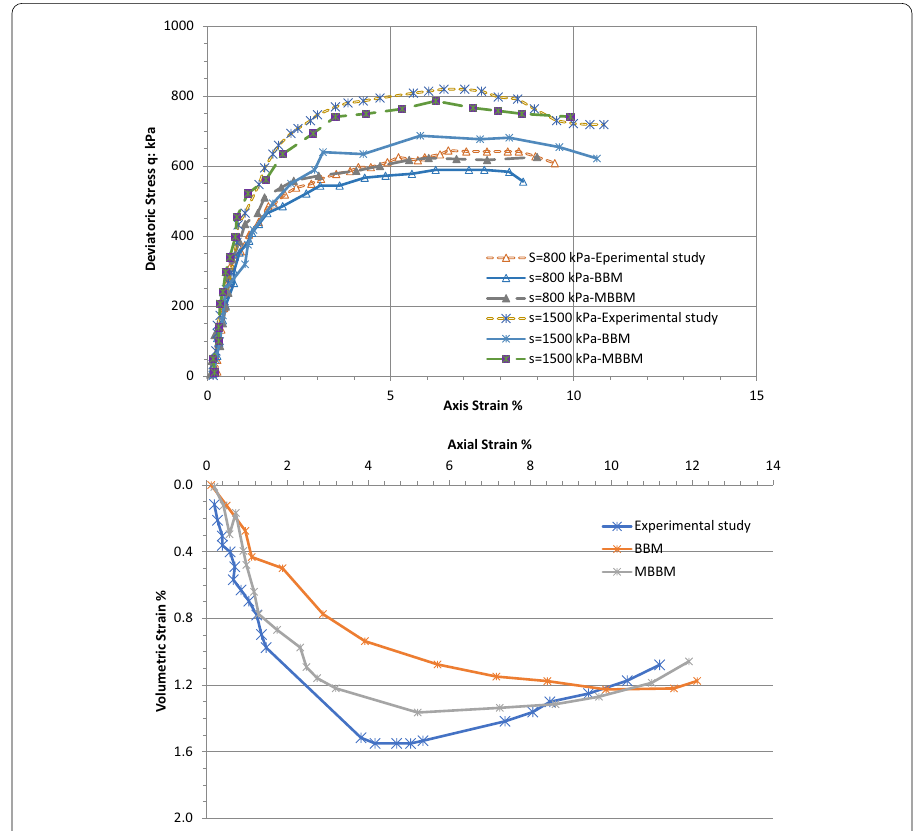
Fig. 20 Comparative curves among experimental, BBM and MBBM for stress–strain and volume change at confining pressure of 100